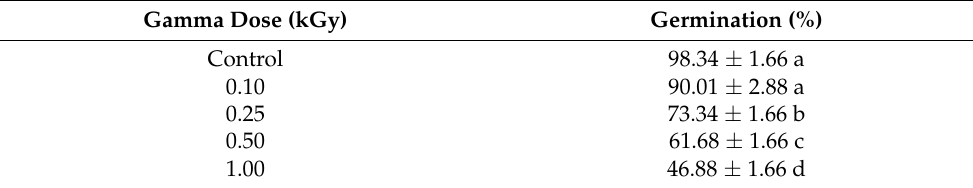
Table 5. Effects of gamma irradiation on germination (%) after 7 days post-treatment.